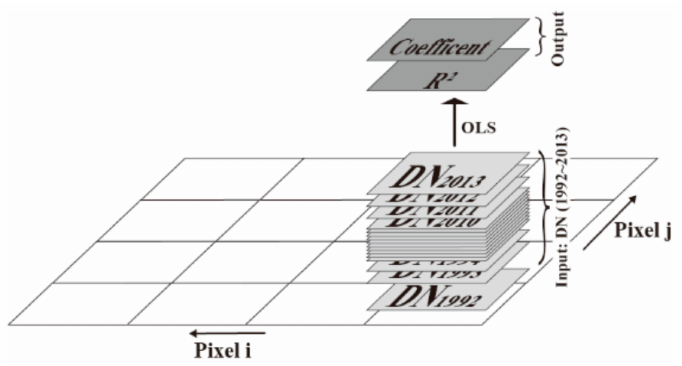
Figure 4. Linear regression of NTL fluctuation at pixel